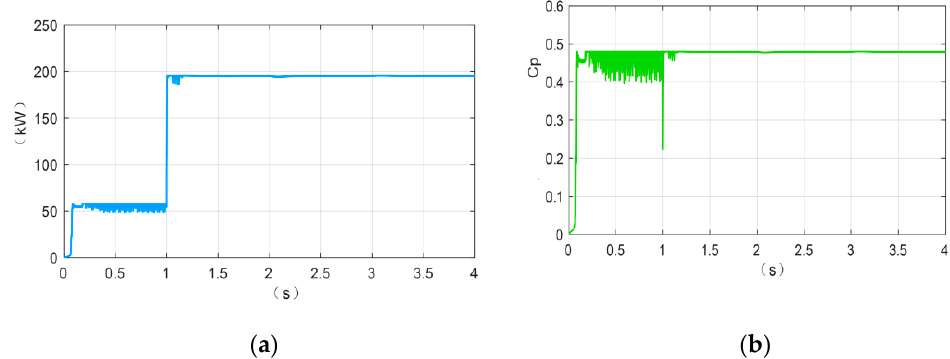
Figure 16. Simulation diagram of wind power generation system. ( a ) Wind power system output power; ( b ) C p curve.